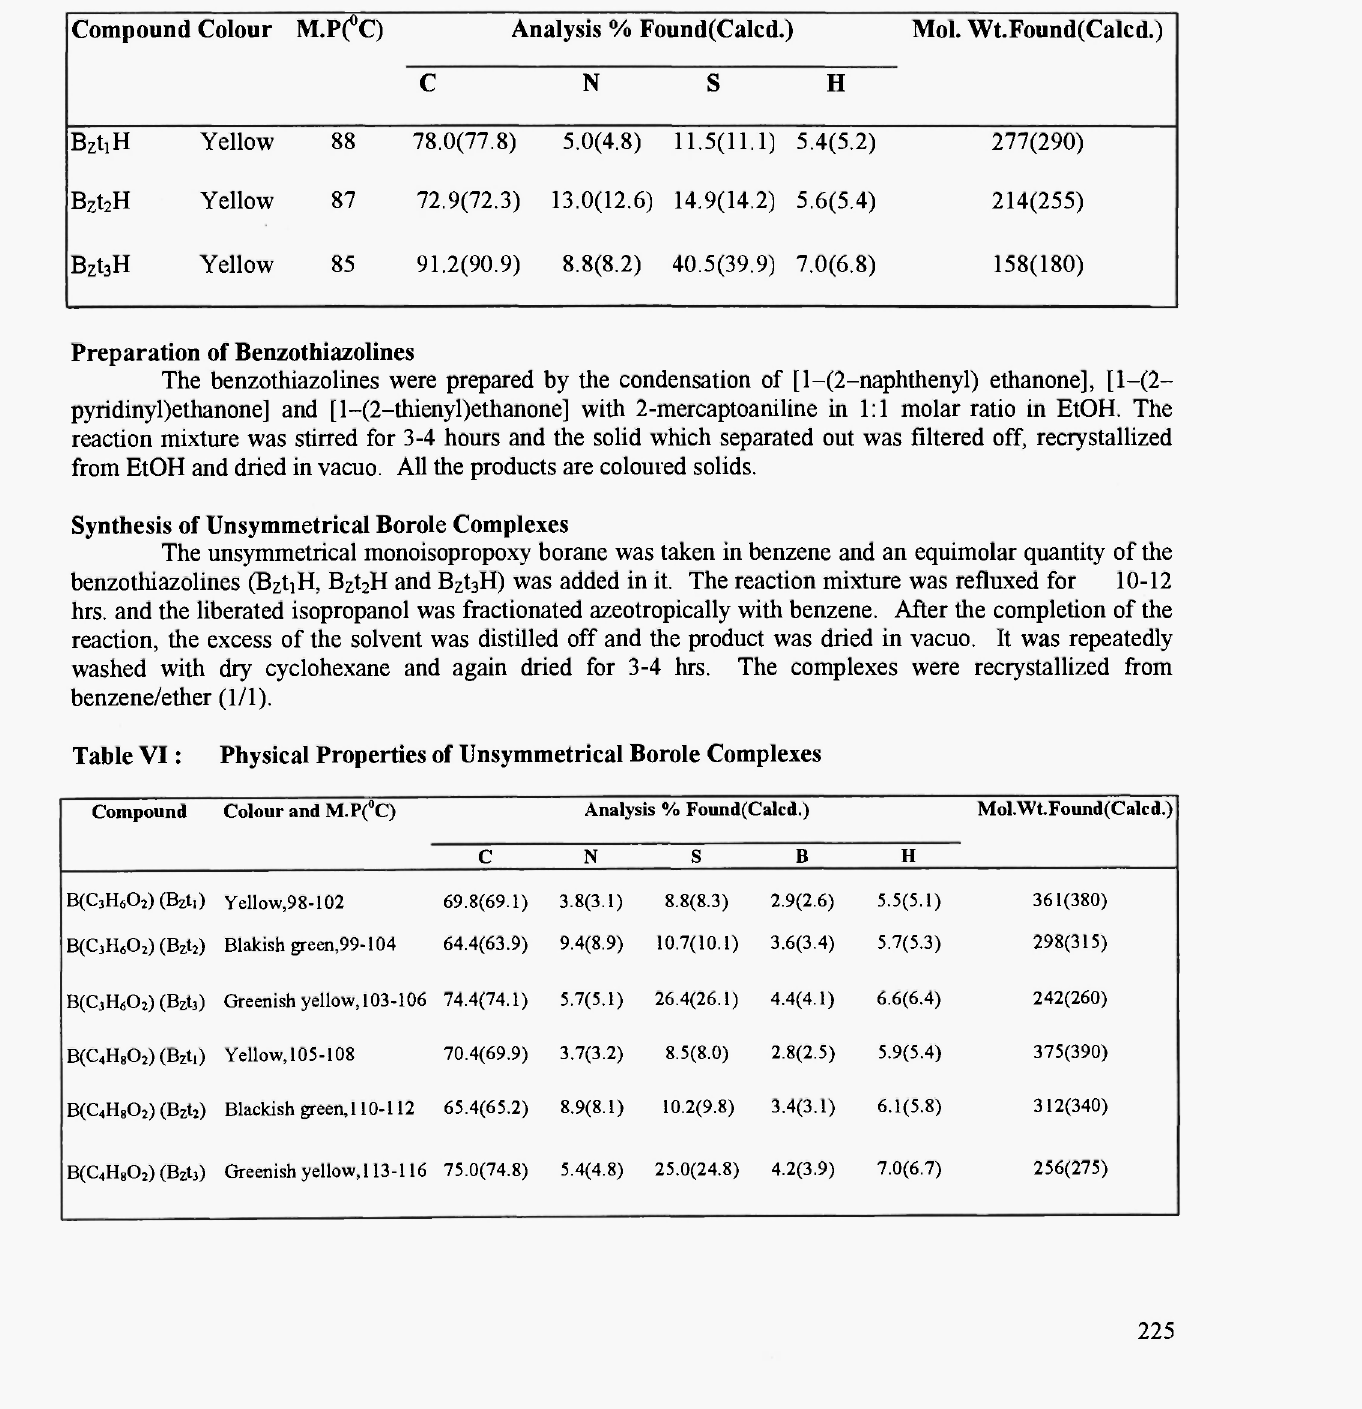
Table V : Physical Properties of Benzothiazolines Compound Colour M.P(°C) Analysis % Found(Calcd.)